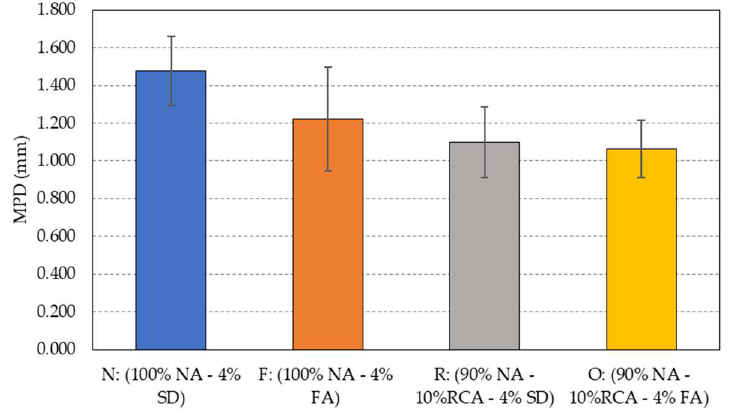
Figure 11. Average MPD of the four porous asphalt mixtures.